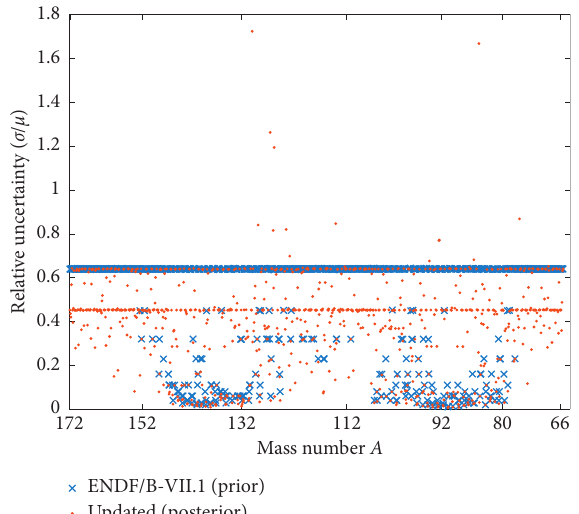
Figure 8: Lognormal distribution of random variable X in terms of its relative uncertainty. Relative uncertainty R � ( σ 10% to 80% and μ X � 2 . 0. Dashed line shows the distribution with relative uncertainty lower than or equal to 40%, whereas solid line indicates the distribution with relative uncertainty larger than 40%.